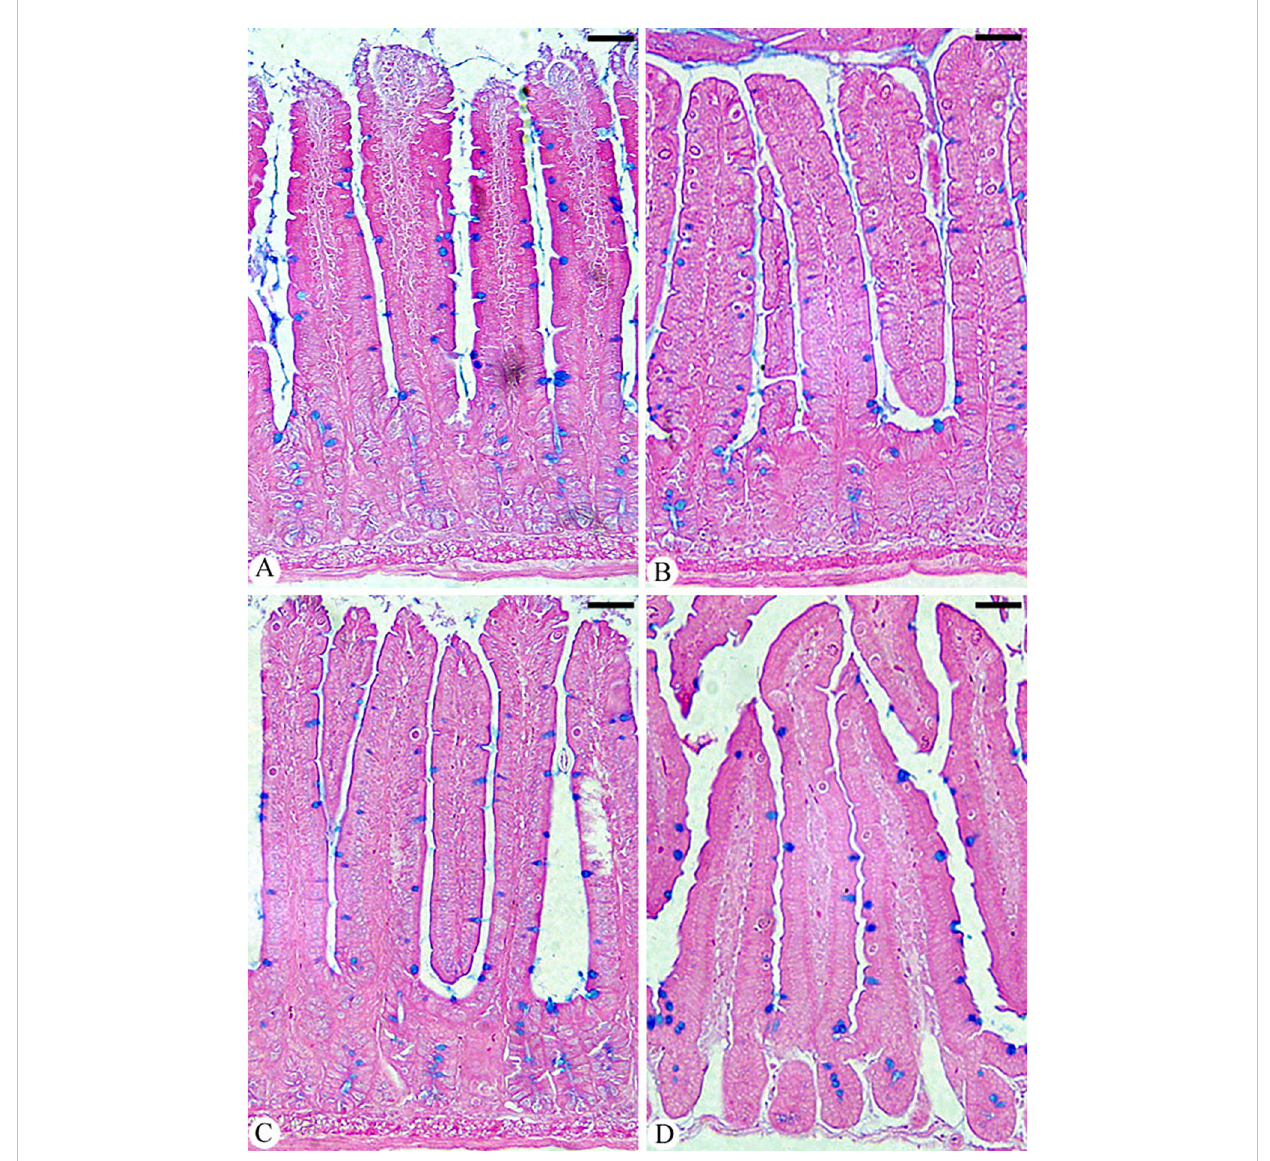
FIGURE 6 Jejunum sections showing goblet cells in (A) control group, (B) infected group, (C) infected group treated with Bio-SeNPs, and (D) infected group treated with AMP. Sections were stained with alcian blue and counted with eosin goblet cells in 10 well-oriented villus-crypt units (VCU). Scale bar =